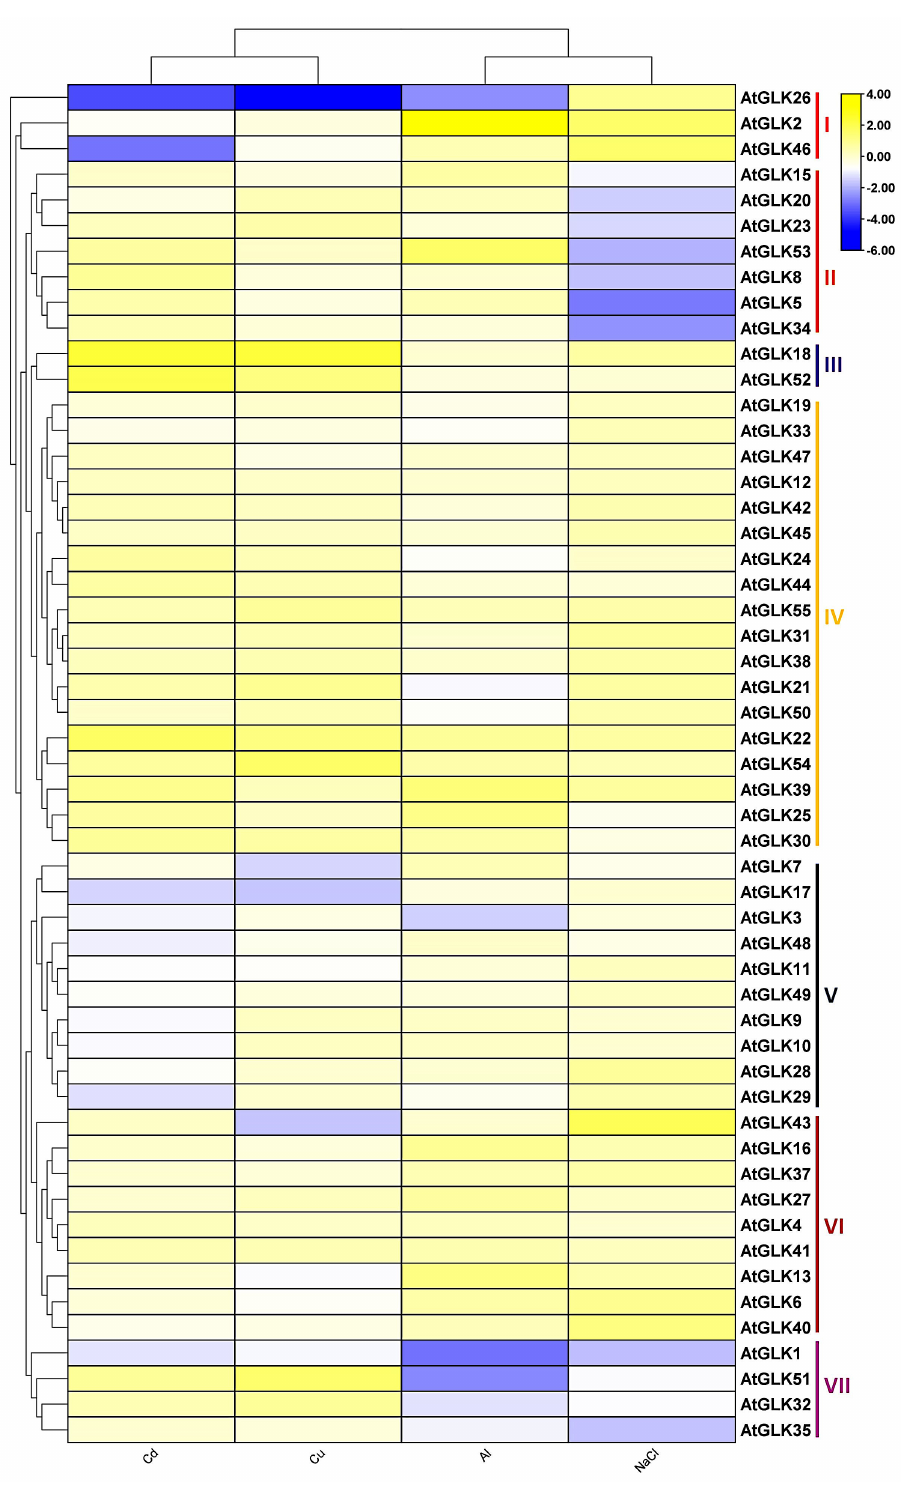
Figure 4. Expression analysis of AtGLK genes in response to ionic stresses in Arabidopsis root. Heatmap was generated from the experimental microarray data. Treatment and replicates were defined by Zhao et al. [37]. In the heatmap, three biological replicates’ intensity values were averaged and z-score transformed based on the control treatment. Control shows non-stressed roots. Yellow and blue color indicates high and low expression levels,